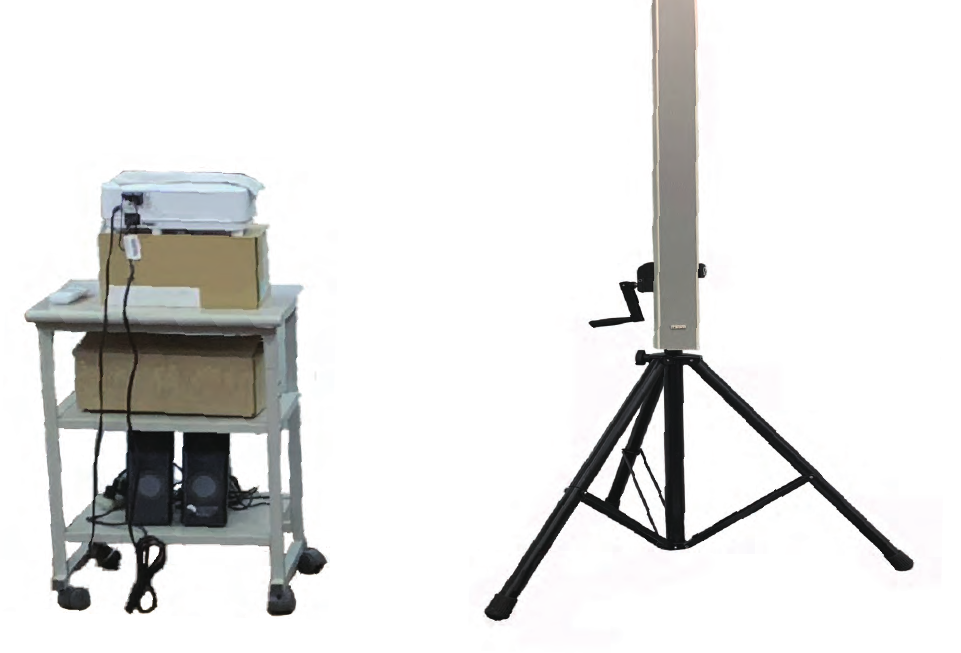
Figure 1. Two sound amplification systems: System A ( left ), and System B ( right ).